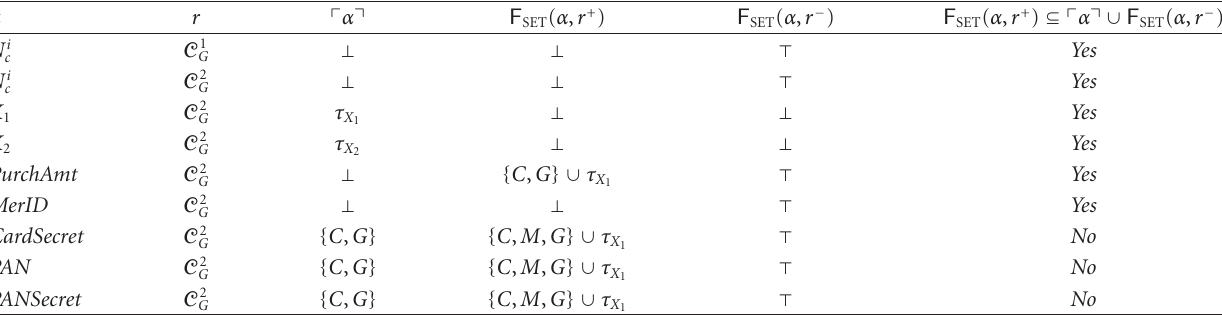
Table 17: SET analysis: role of C .